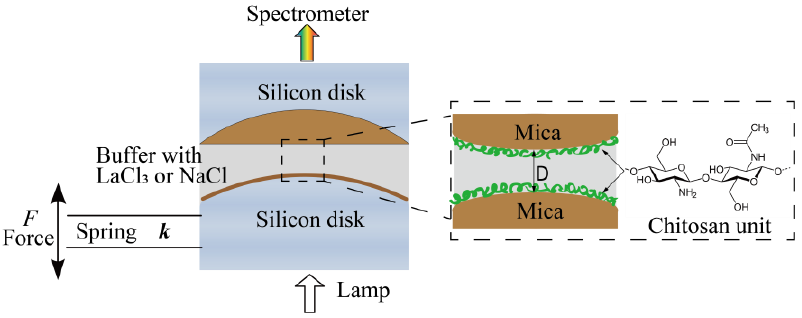
Figure 1. Schematic of the experimental setup and chemical structures of chitosan.